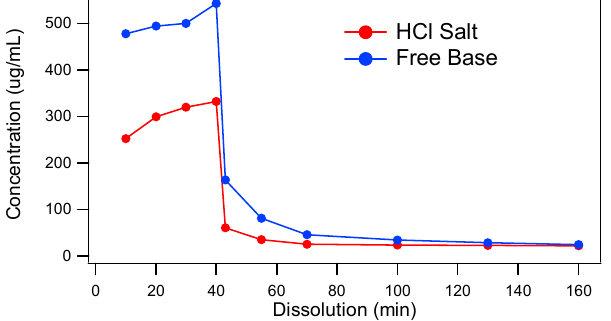
Figure 1. Two-stage dissolution of MK-A HCl Salt and Free Base.